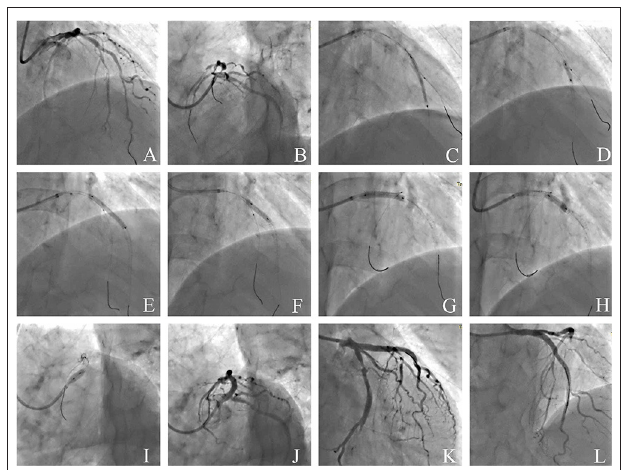
FIGURE 7 | Coronary angiography illustrating the JB-POT in the intervention of a complicated bifurcation lesion. (A,B) Baseline angiography of diffused LAD-LM lesions with 3 true bifurcations (LAD-D1, LAD-S1, LAD-D2); (C) deploying a 2.5 × 29mm DES crossing D2 with a 1.5 × 15mm balloon jailed in D2; (D) post-dilation and JB-POT of the first stent with 2.5 × 12mm and 3.0 × 12 non-compliant balloons; (E) deploying a 3.0 × 29mm DES crossing D2 with a 1.5 × 15mm balloon jailed in D2; (F) JB-POT of the 3.0 stent with a 3.5 × 12 NC balloon, re-POT the 2.5mm stent and post-dilation of the 3.0mm stent with a 3.0 × 15 NC balloon; (G) deploying a 3.5 × 24mm DES crossing LCX with a wire jailed in LCX; (H) post-dilation of the 3.5mm stent and re-POT of the 3.0mm stent with a 3.5 × 12 NC balloon; (I) performing POT in LM with a 5.0 × 10 NC balloon; (J–L) final angiographic results. JB-POT, jailed balloon proximal optimization technique; LAD, left anterior descending coronary artery; LM, left main coronary artery; D1, the first diagonal -branch; D2, the second diagonal branch; S1, the first septal